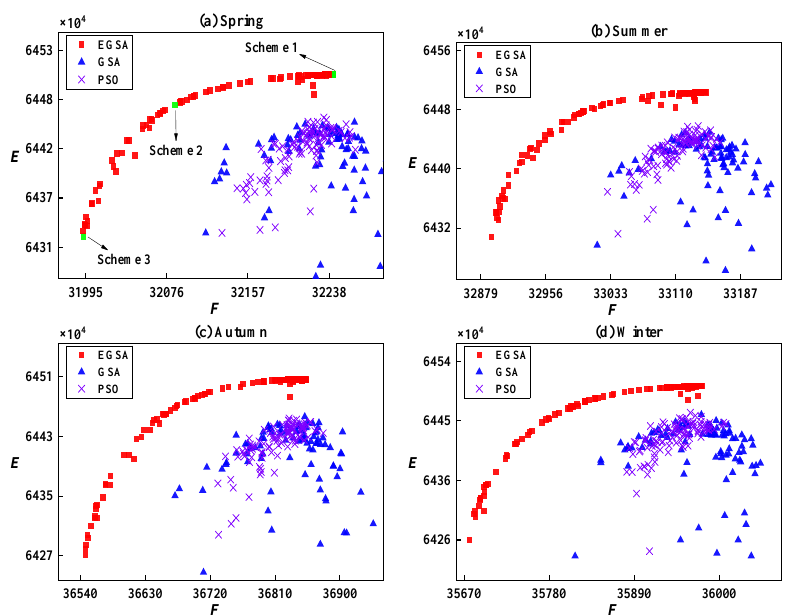
Figure 11. Distributions of the objective functions obtained by different methods with 100 weights.